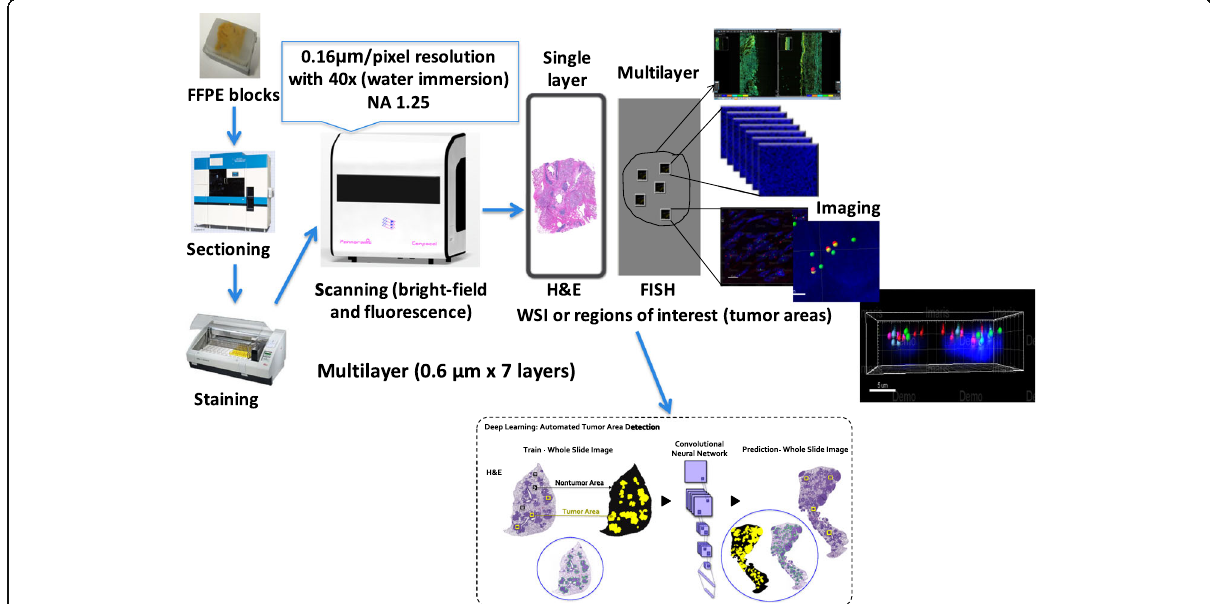
Fig. 1 Workflow of tissue sectioning, staining and scanning. Serial sectioning of FFPE tissue blocks was used for H&E or IHC staining in order to characterize the region of interest. H&E and IHC slides were scanned at wide-field mode with 20× water immersion objective at a single layer. ROIs on FISH slides were scanned at confocal mode with multiple layers ( N = 7 layers at 0.6 μ m interval) with 40× water immersion objective and a final image resolution of 0.16 μ m/pixel. Three filters were chosen: DAPI (blue), FITC (green) and TRITC (red). Showing in a dashed line frame: